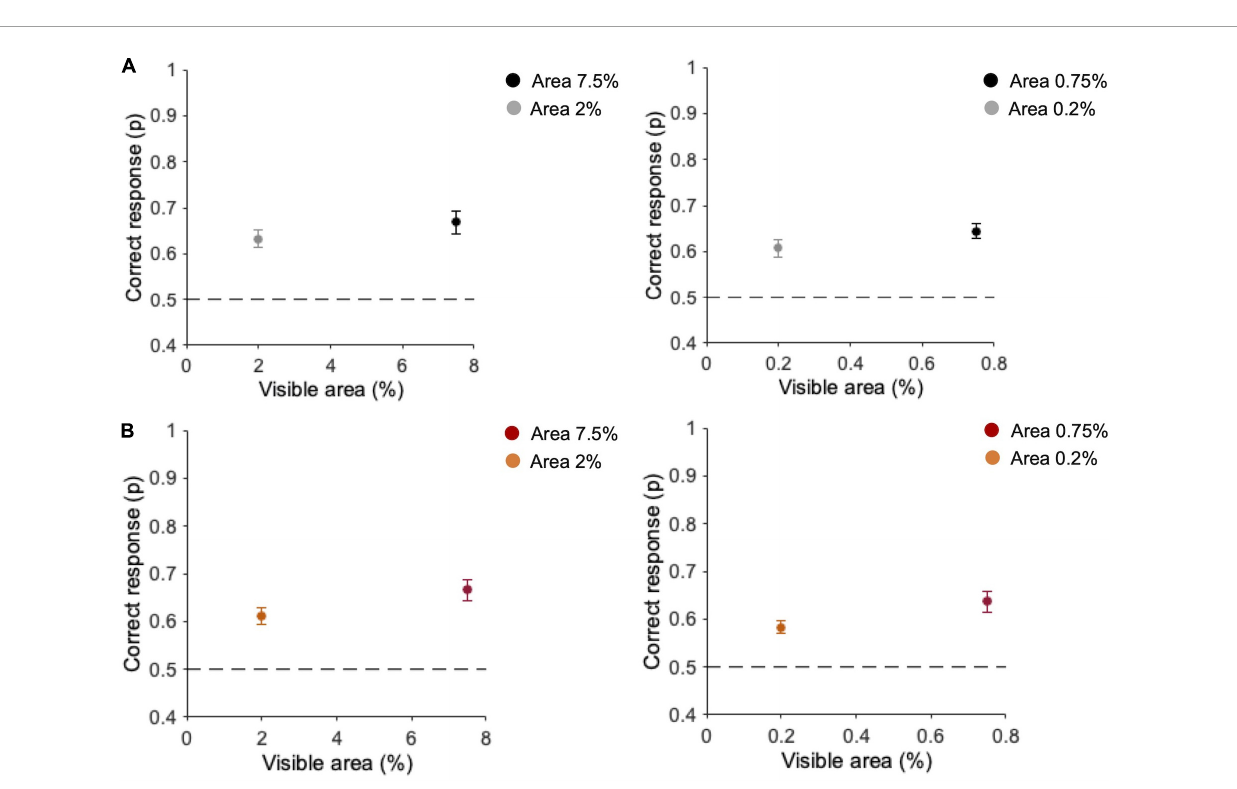
a 2IFC task, the order of target presentation might affect the performance, as well as the frequency of occurrence of each image: repeated presentations of the same image as target or distractor might induce visual learning of the images. For the task with original contrast images, we then performed a GLMM with three fixed factors: SNR-contrast difference (standardized), target order presentation, and image repetition number. Participants and stimuli were included as random effects. The GLMM reveals no effect of the difference between standardized SNR and contrasts [ χ 2 (1) = 0.24, p = 0.62], but a main effect of order [ χ 2 (1) = 9.1, p = 0.002] and image repetition number [ χ 2 (1) =